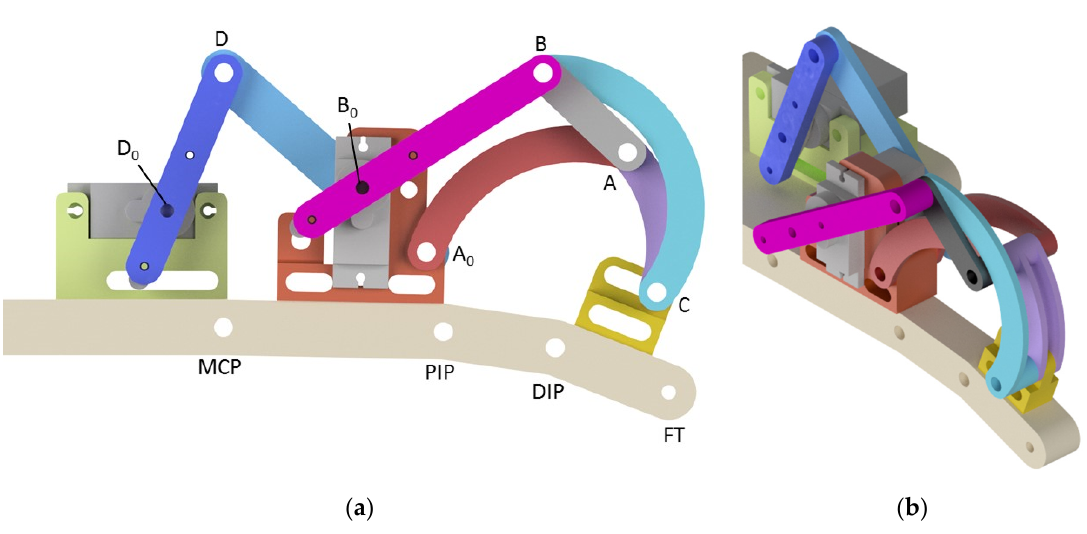
Figure 14. Schemes for force distribution analysis: ( a ) a CAD front view of the second linkage (A0AB0B); ( b ) an overall free body diagram; ( c ) free body diagrams of single elements.